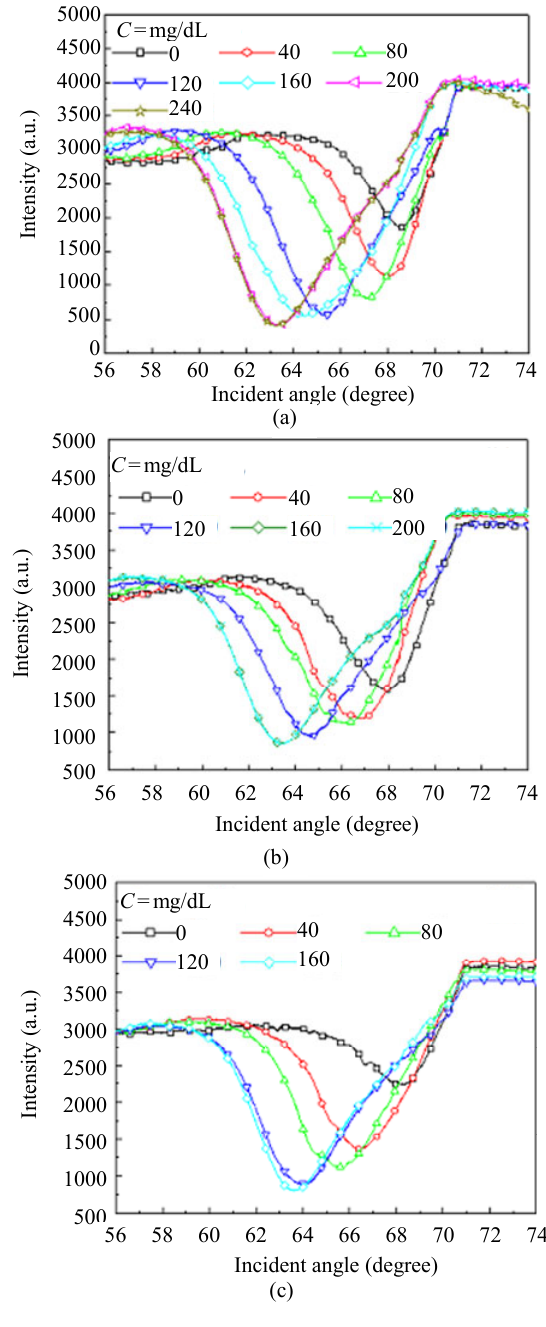
Fig. 6 Resonance spectra of the GSMs with different component rates of SiMCFs and SiNPs: (a) 7 : 3, (b) 5 : 5, and (c) 3 : 7.